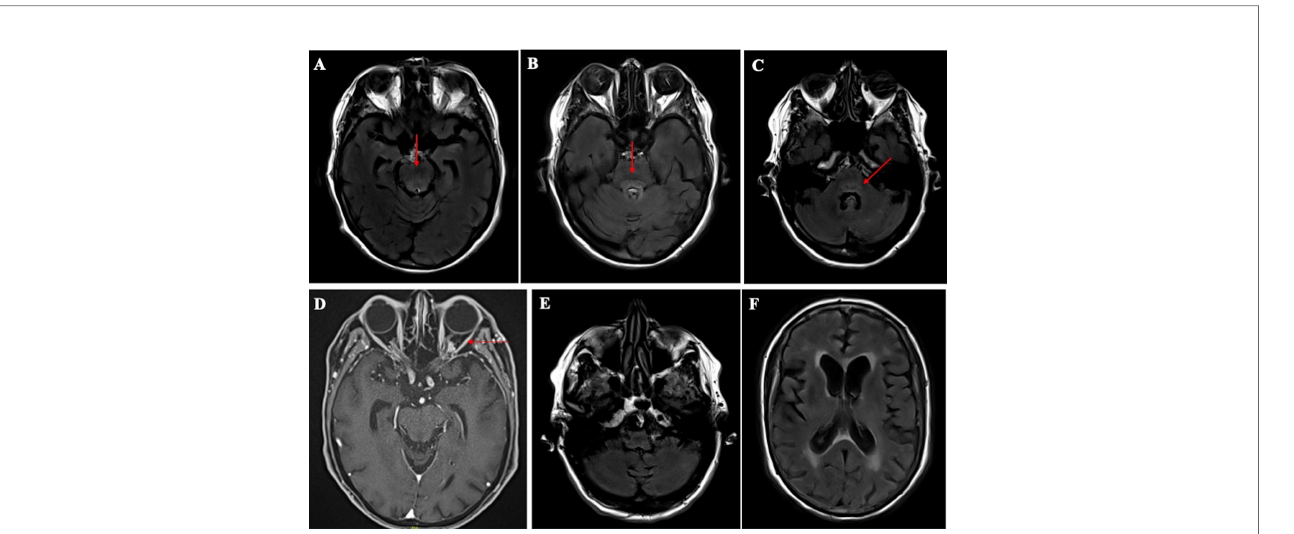
FIGURE 2 | Radiological brain imaging of the ECD patient at diagnosis. (A) Axial brain MRI showing a hyperintense signal in the pons on the T2-FLAIR sequence. (B) Axial brain MRI showing a hyperintense signal in the pons on the T2-FLAIR sequence. (C) Axial brain MRI showing a slight hyperintense signal on the T2-FLAIR sequence on the upper cerebellum. (D) Axial brain MRI showing left orbital pseudotumor in fat-saturated post-gadolinium T1 imaging. (E) Axial brain MRI showing no signs suggestive of cerebellum atrophy on T2 FLAIR sequence. (F) Axial brain MRI diffuse cortical atrophy predominant in the parietal lobes, with leukoaraiosis (Fazekas grade II) of presumed vascular origin.